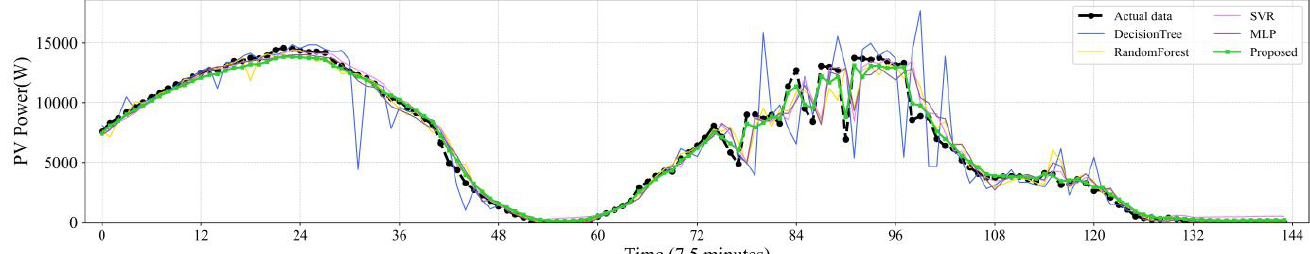
Figure 8. Contrasting the performance evaluation of the proposed model and machine learning models.